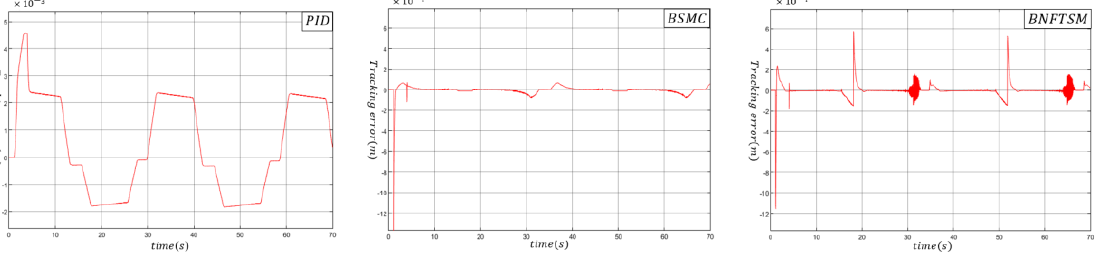
Figure 8. Tracking error curves of three controllers under 4000N constant load force: PID, BSMC, BNTFSM.